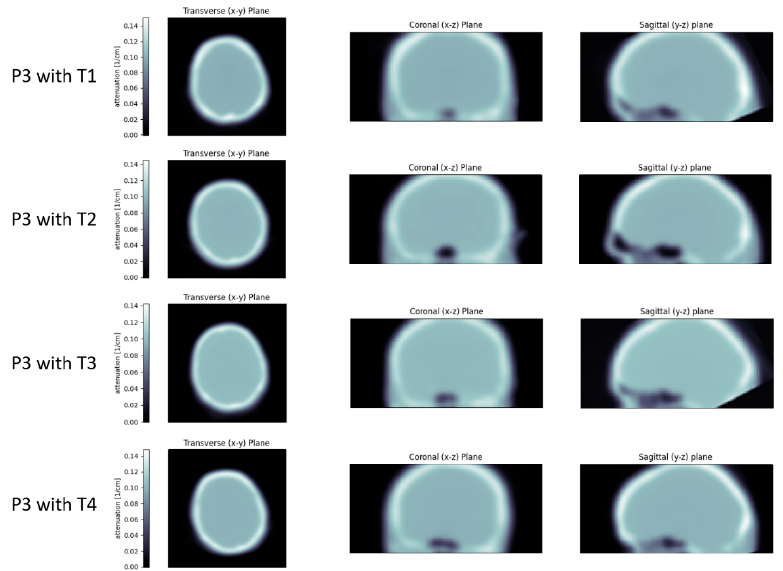
Figure 11. The attenuation maps obtained for patient P3 with the four templates. It is clearly visible that a part of the neck is not covered by the reference PET/CT scan of template T3 (and to a lesser degree also of template T1), and therefore results in a gap in the attenuation map.